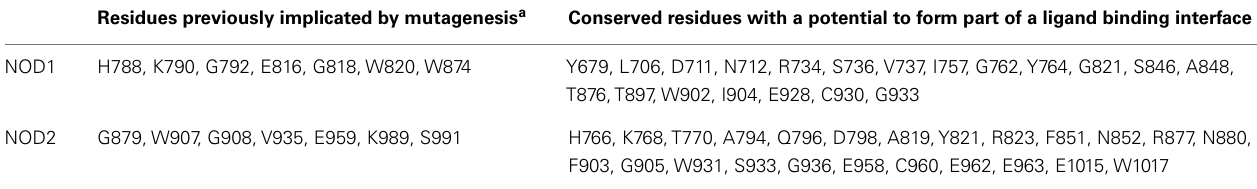
Table 3 | Residues contributing to potential ligand binding patches on NOD1 and